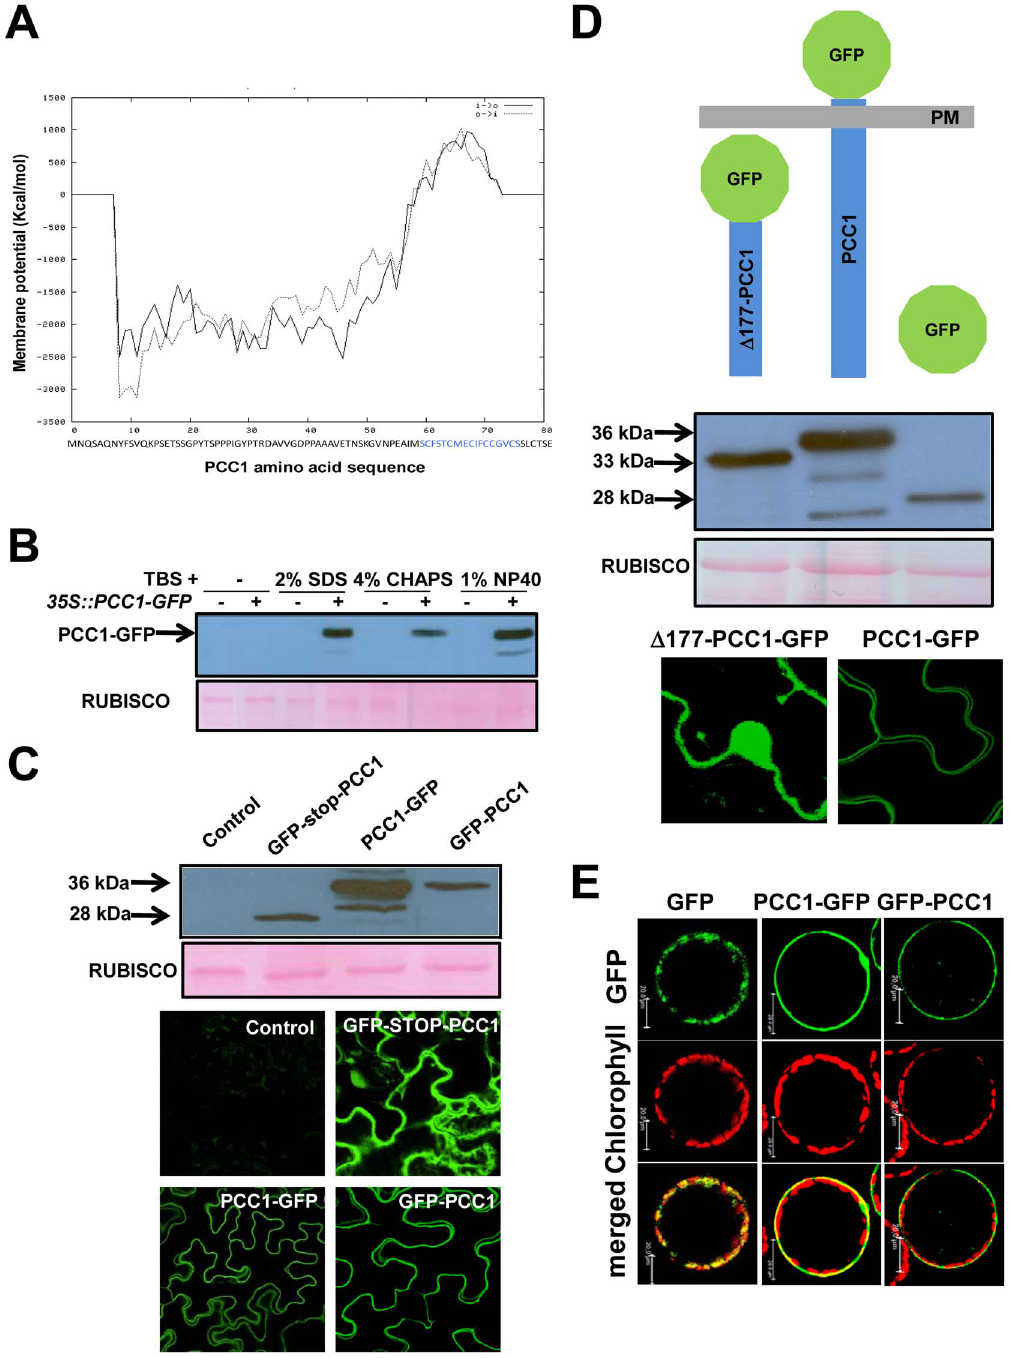
Figure 1. Plasma membrane localization of PCC1 protein. (A) Bioinformatic prediction of transmembrane potential for PCC1 using TMPred tool. The C-terminal domain with positive potential is written in blue in the amino acid sequence below the plot. (B) Extraction of PCC1 protein from Nicotiana benthamina leaves transiently transformed with 35S::PCC1-GFP construct was assessed by using TBS buffer supplemented or not with different detergents as indicated, and further detected by Western blot with anti-GFP antibodies. Ponceau S-stained Rubisco is shown as loading control. (C) Expression of GFP-tagged versions of PCC1 in its C- (PCC1-GFP) and N-terminus (GFP-PCC1) as wells as the free GFP control (GFP-stop- PCC1) was analyzed by Western blot with anti-GFP antibodies and confocal microscopy. (D) Expression of a GFP-tagged truncated PCC1 version ( D 177-PCC1-GFP) without the potential C-terminal membrane-associated domain leads to cytoplasmic localization instead of the membrane localization for the whole GFP-PCC1 protein. (E) Isolation of protoplasts from transiently transformed Nicotiana benthamina leaves confirmed the plasma membrane association of PCC1 and allowed to rule out cell wall localization.